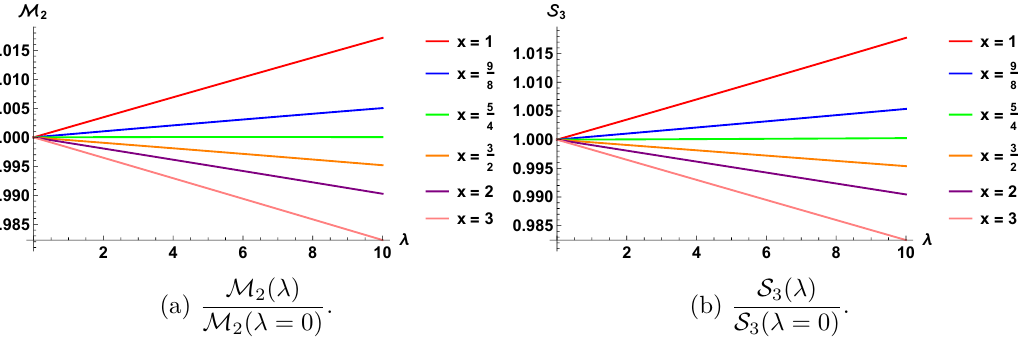
and S (normalized with respect to their λ = 0 black hole values) Figure 3 : Plots of M 2 3 as a function of λ for h = 433 / 500 , n = 1 , and x taking on various values indicated by the